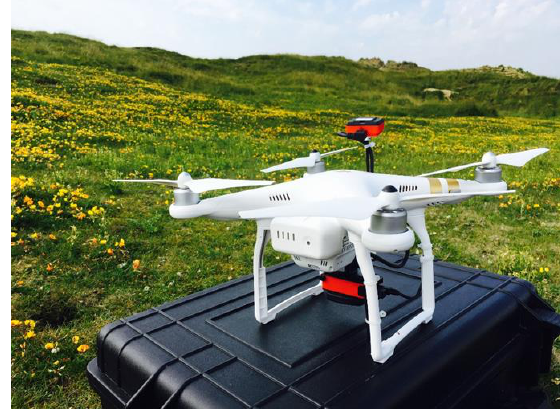
Figure 2. Sequoia multispectral sensor mounted on DJI UAS.